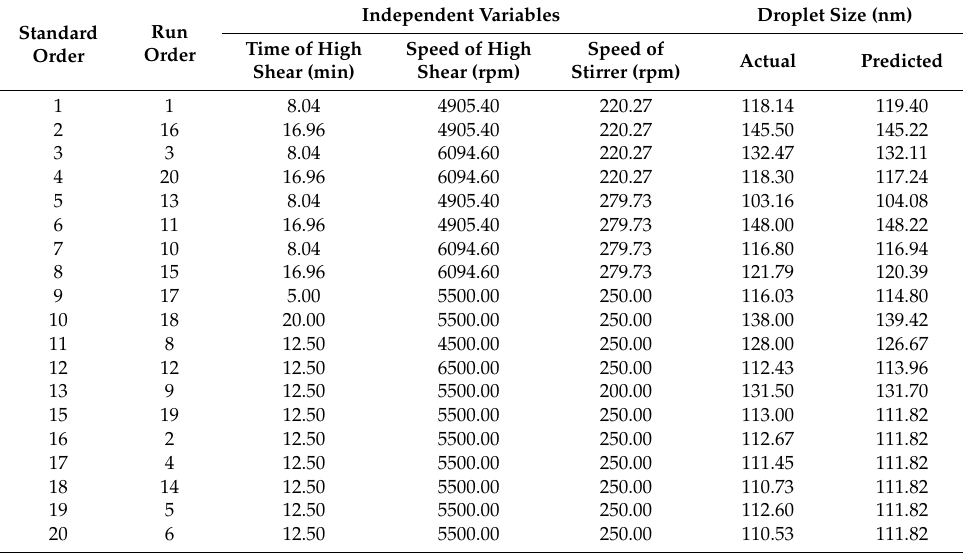
Table 1. Experimental data actual and predicted values of the droplet size of the kojic monooleate (KMO)